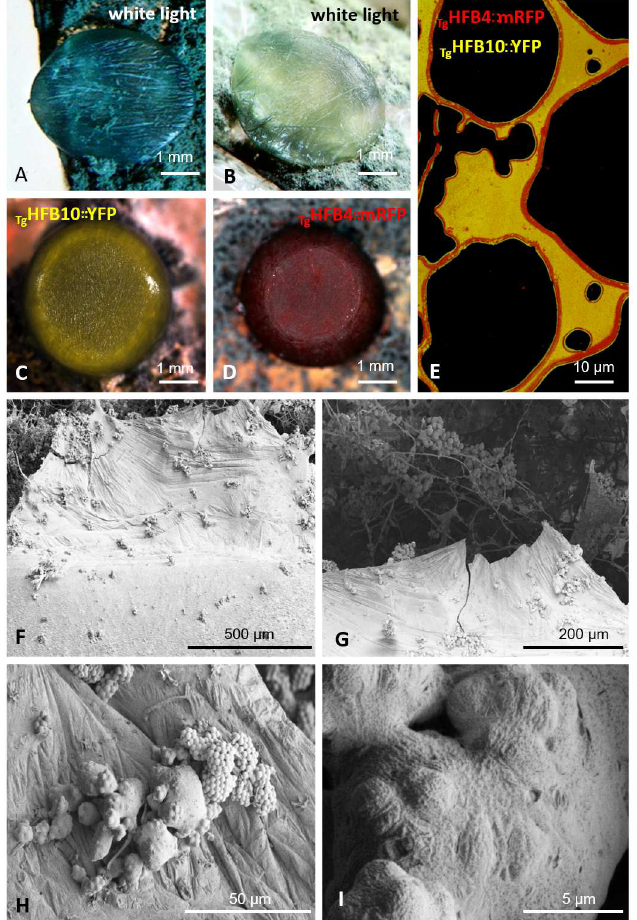
Fig 6. HFB-containing macroscopically visible films on the surface of water drops applied on the sporulating colonies of Trichoderma spp. (A) and (B) Droplets of 10 μ l of water applied on the conidiating areas of T . guizhouense and T . harzianum colonies imaged 10 min after exposure to the open air at room temperature. (C) and (D) The stereo confocal microscopy images of 10 μ l of water droplets applied on the conidiating areas of Tg hfb10 :: yfp and Tg hfb4 :: mrfp strains, respectively. (E) The fragment of the film formed by Tg hfb4 :: mrfp— Tg hfb10 :: yfp after it was destroyed by the cover glass and imaged in epifluorescent microscope. (F)–(G) and (H)—(I) are the films shown in (A) and (B), respectively, observed in